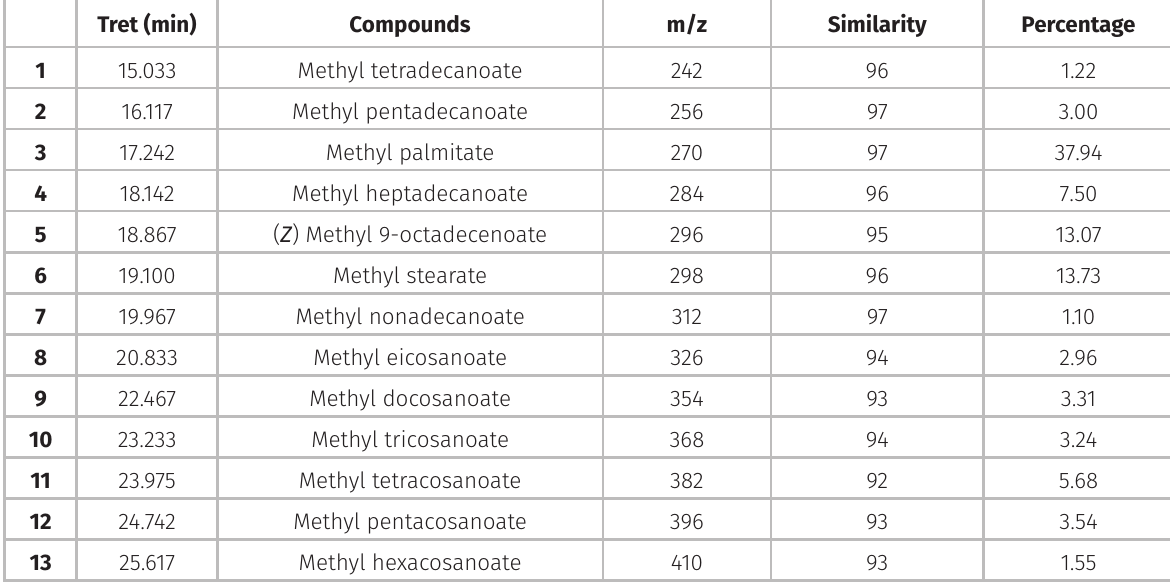
O-H 10-11 fraction. 2